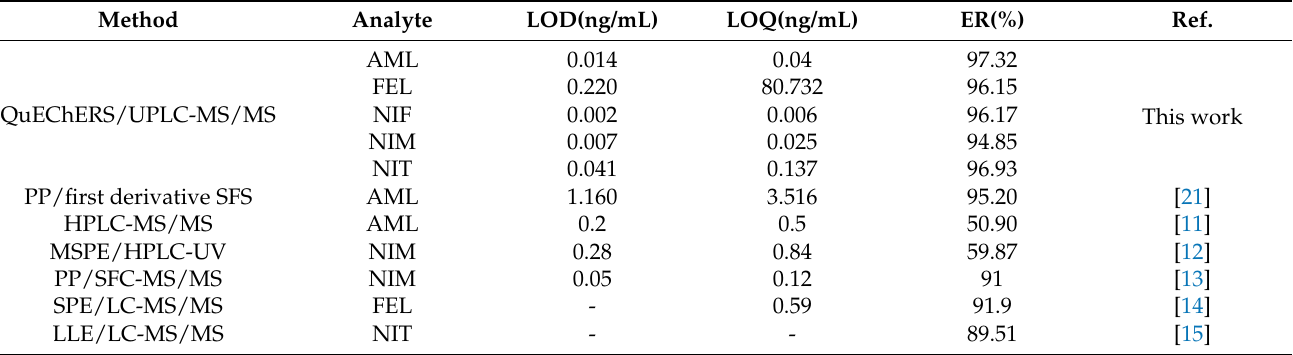
Figure 4. The area results of five CCBs treated with different amounts of MgSO 4 . Few methods for the simultaneous determination of five calcium antagonists have been established in the last five years of research. Most of the methods in Table 4 measured one-three drugs and included only one calcium antagonist. The method we established allows simultaneous determination of five CCBs, which indicates that our method covers an extensive range of drugs and is more applicable. The developed method has LOD and LOQ of 0.014, 0.048 for AML, and 0.007,0.025 for NIM. Existing studies have shown LOD and LOQ greater than 0.2 and 0.5 for AML [11,12] and greater than 0.05 and 0.12 for NIM [13,14]. The new method demonstrated lower LOD and LOQ and, therefore, has higher sensitivity than published methods. The extraction recoveries of each drug in this method were more than 94%, which was higher than those of the corresponding drugs in other studies in Table 4. Table 4. Comparison of the proposed method with other published methods for the quantitative detection of